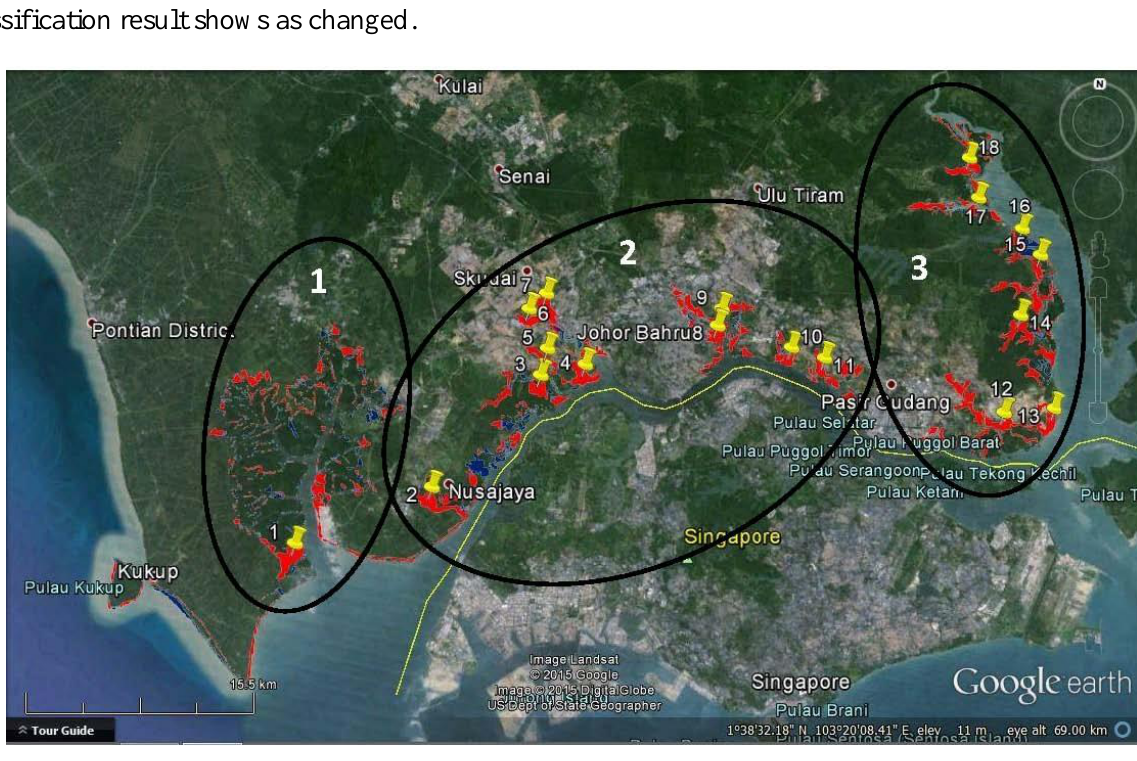
Figure 9. Locations of changed mangrove area as detected from satellite images (red and blue areas refer to mangrove loss and gain, respectively, between 1989 and 2014) overlaid on a Google Earth image. Black circles numbered as 1, 2 and 3 show the major mangrove areas (refer to Table 5) in Iskandar Malaysia. The yellow pincushions show the specific locations of changed mangrove areas that were verified with Google Earth images (refer to Table 6 for the specific